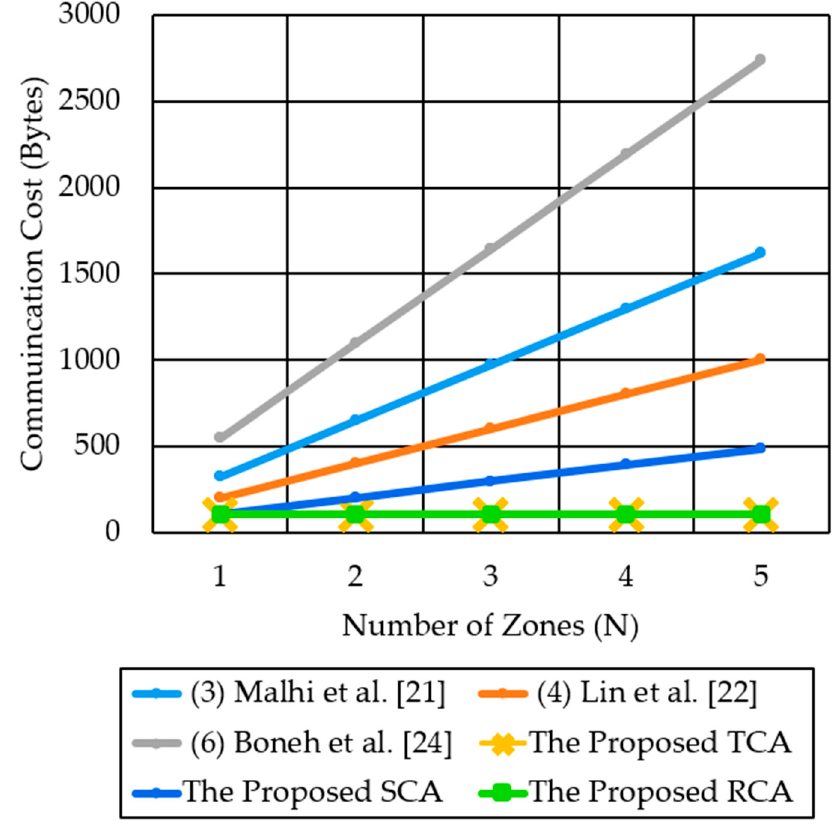
Figure 12. Comparison of communication cost for the proposed authentication methods and the compared security protocols for the multi-zone scenario.